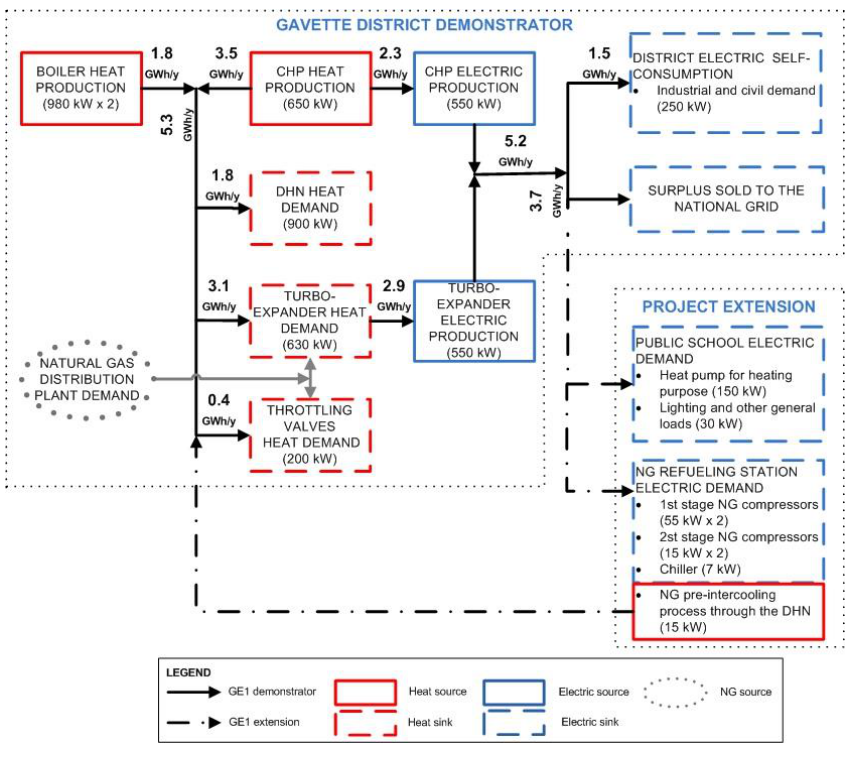
Figure 2. GE1 energy flows.